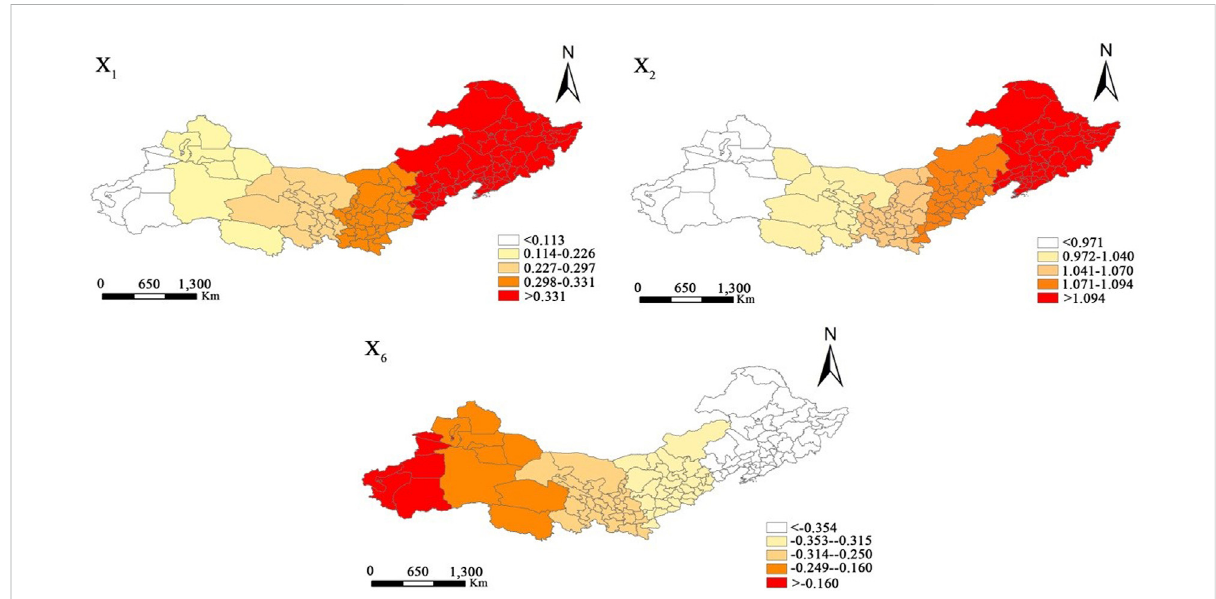
FIGURE 7 Spatial Distribution of Regression Coef fi cients of the GWR Model (2012).